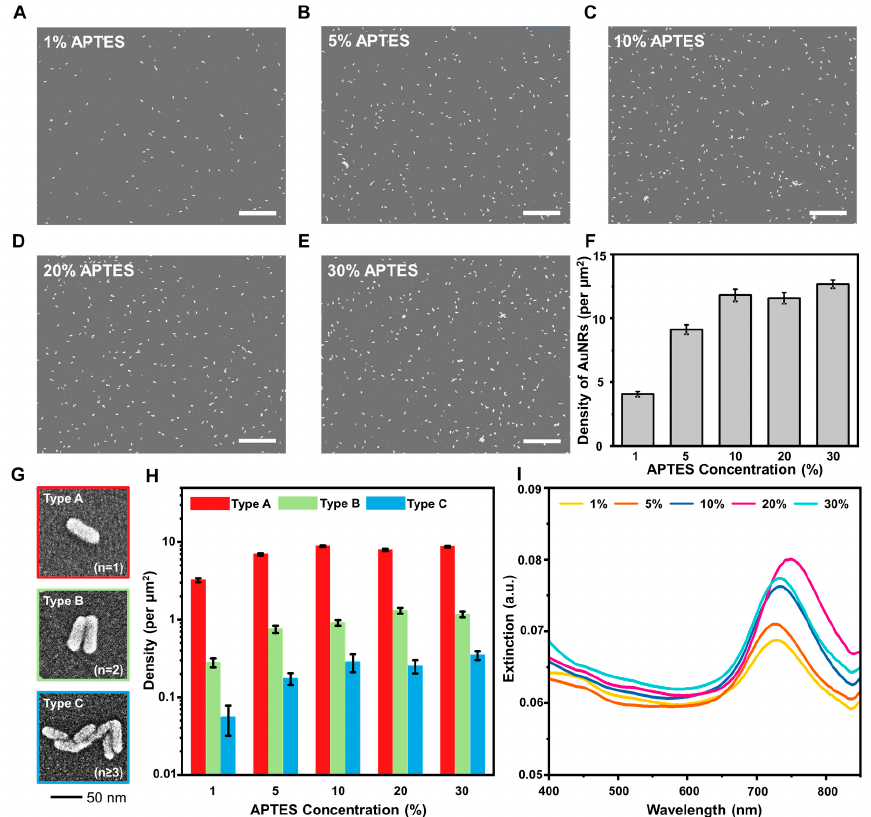
Figure 2. ( A – E ) SEM images of deposited AuNRs on glass substrate as a function of the APTES concentration (1–30% v / v in ethanol) used during fabrication. Scale bars are 1 µm. ( F ) Surface density of deposited AuNRs on the glass substrate as a function of APTES concentration and expressed in terms of nanorods per µm 2 . ( G ) Representative SEM images corresponding to deposited AuNRs in different aggregation states that are defined as Type A (individual AuNR), Type B (two AuNRs adjoined together), and Type C (three or more AuNRs adjoined together). ( H ) Surface density of deposited AuNRs in the different aggregation states based on the data in panel ( G ). ( I ) Optical ex- tinction spectra of deposited AuNRs on glass substrate as a function of the APTES concentration. Data in panels ( F ) and ( H ) are reported as the mean ± standard deviation from three experiments.